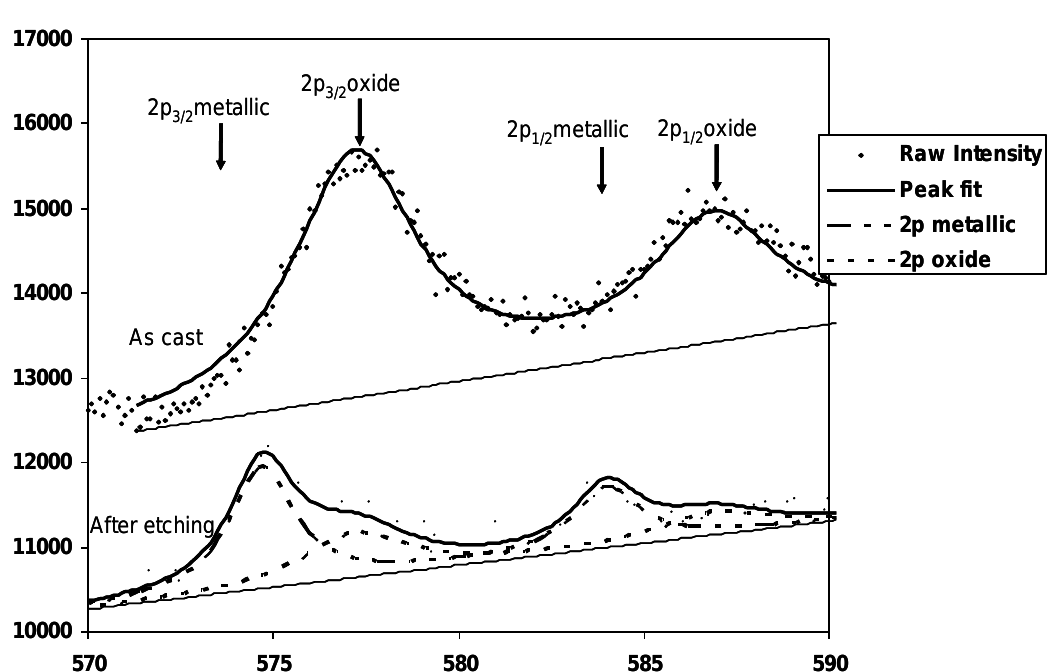
Figure 9. XPS Cr 2p peak fitting for standard Cr and Cr ion